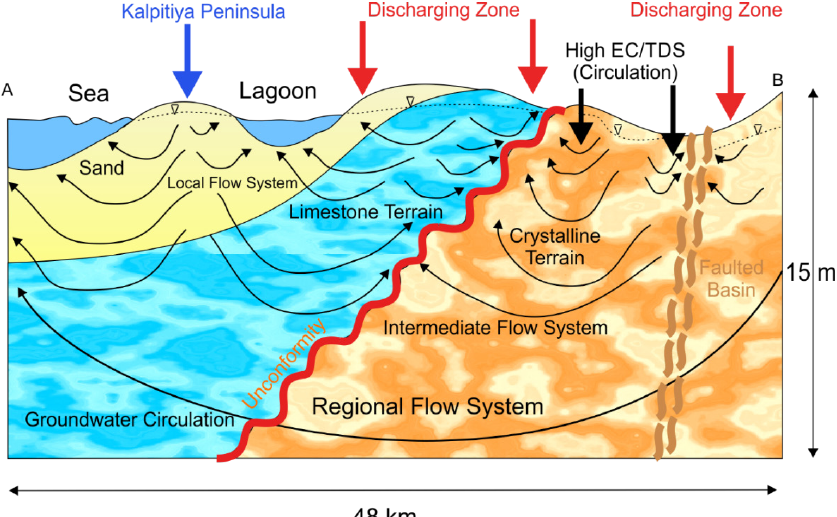
Figure 8: Schematic section of the study area demarcating different flow regimes.